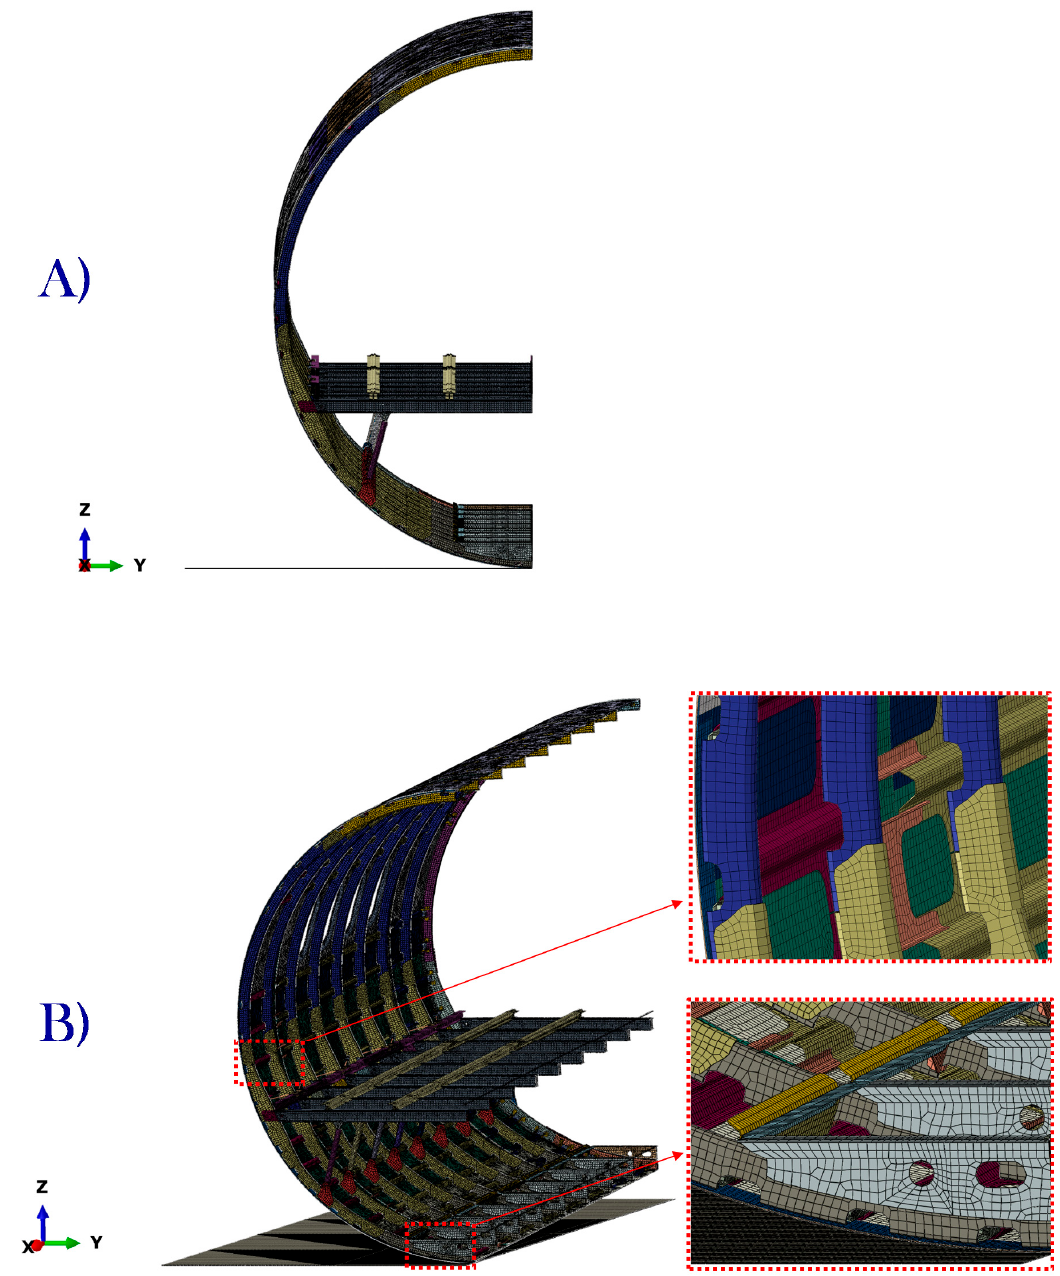
Figure 4. Fuselage mesh model subsection: A) Frontal view. B) Isometric view. C) Stringer view. D) Stringer section.